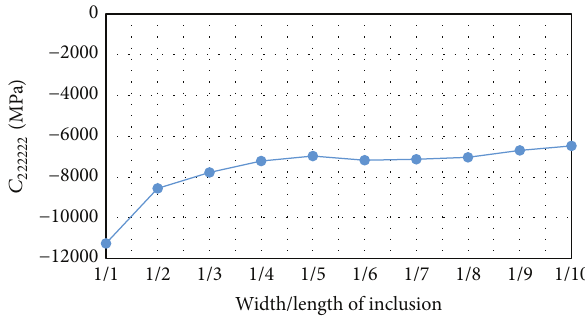
(1) 𝐶 222222 forreinforcedplexiglas